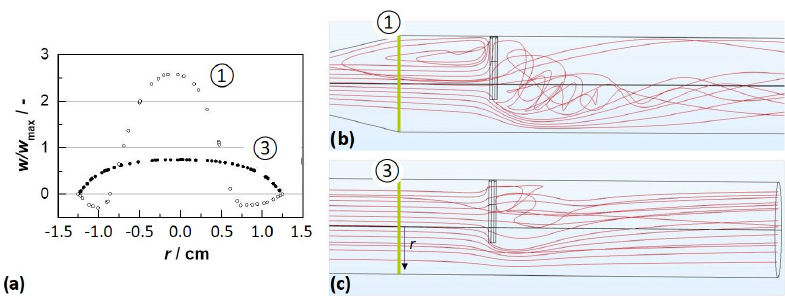
Figure 4. Cross-sectional side view of simulated gas flow lines in the setup described (Fig. 3) for 90 ◦ sensor mounting at position (1) and position (3) (b, c) and evaluated gas velocity over the inner diameter 2.5cm in front of the sensor (green line) for both cases (a) .